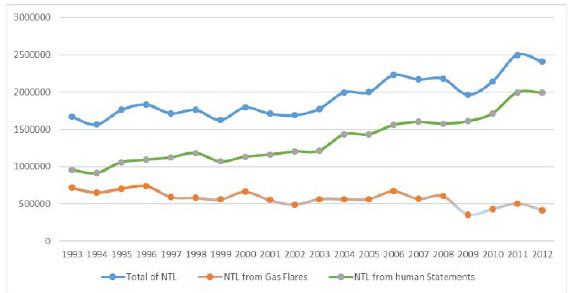
Figure 7. Zoom area north central of Algeria